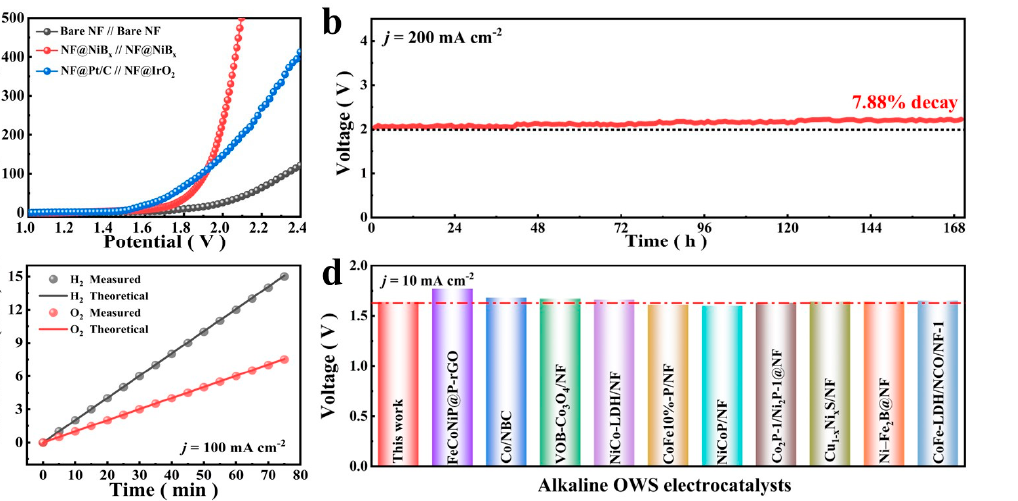
Figure 4. ( a ) LSV curves of OWS for NF@NiB||NF@NiB, Bare NF||Bare NF